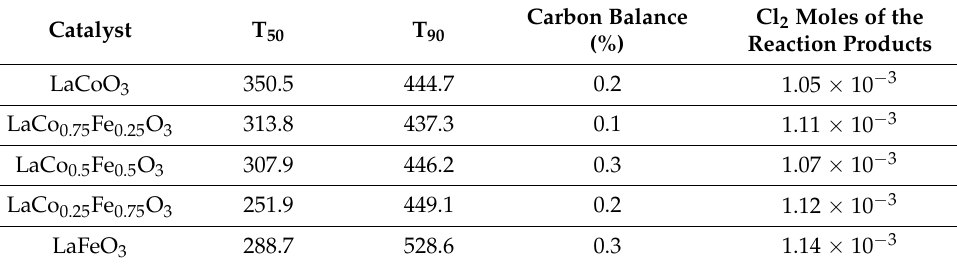
Figure 1. Catalytic activity results. Chlorobenzene conversion vs. reaction temperature. Table 1. T 50 , T 90 , carbon, and Cl 2 balances for the synthesized catalysts.